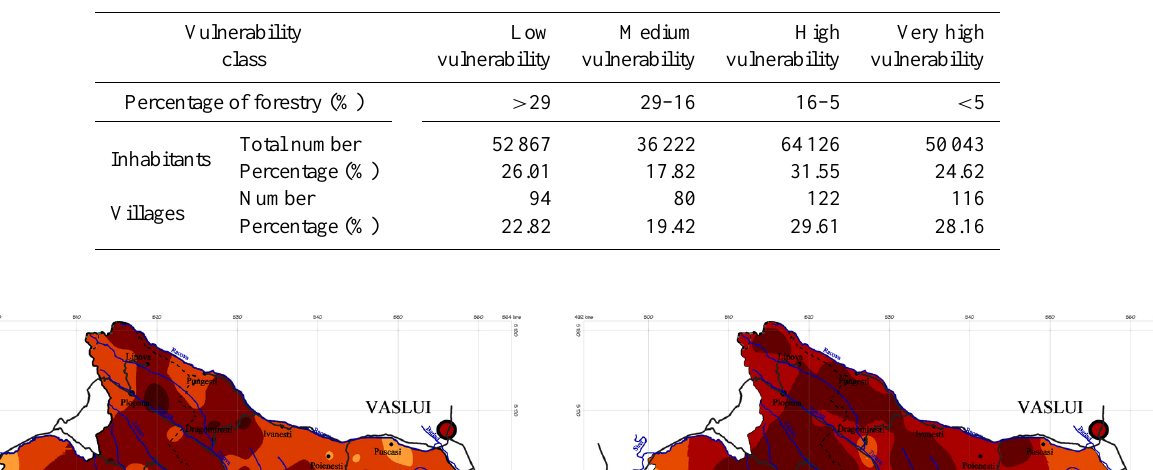
Table 5. Synthetic data on vulnerability factor 4 in Tutova Hills.